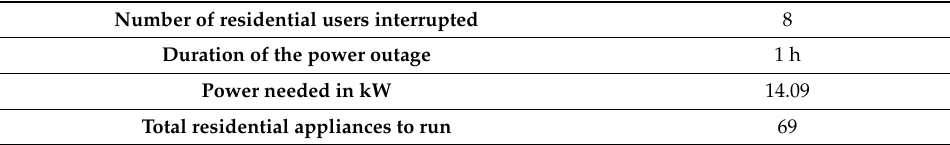
Figure 6. Voltage profile at hour 16 before and after load shedding. Table 4. Status of the test system during an outage without EVs.